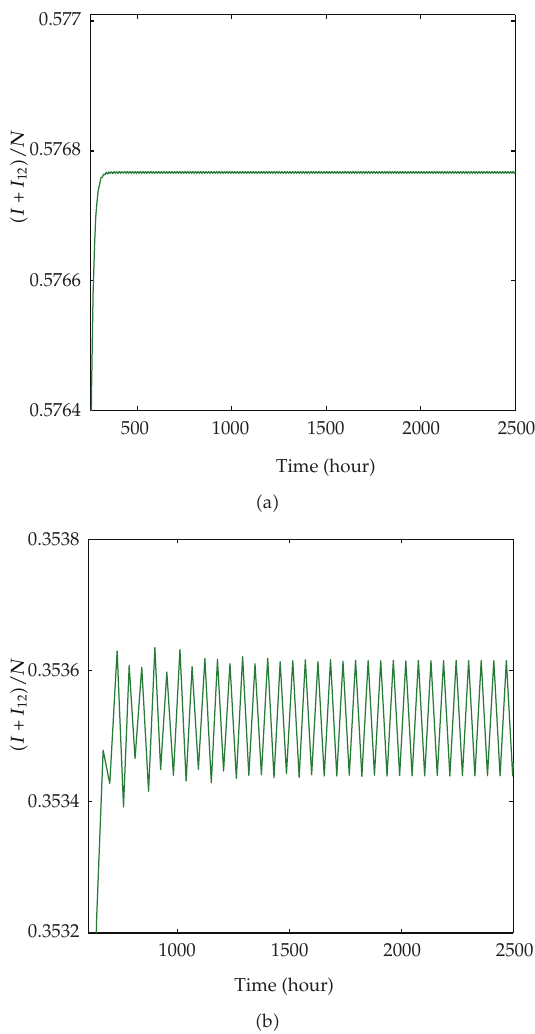
Figure 4: Fraction of computers infected with noncooperative worm: (cid:3) a (cid:4) β 1 > β st